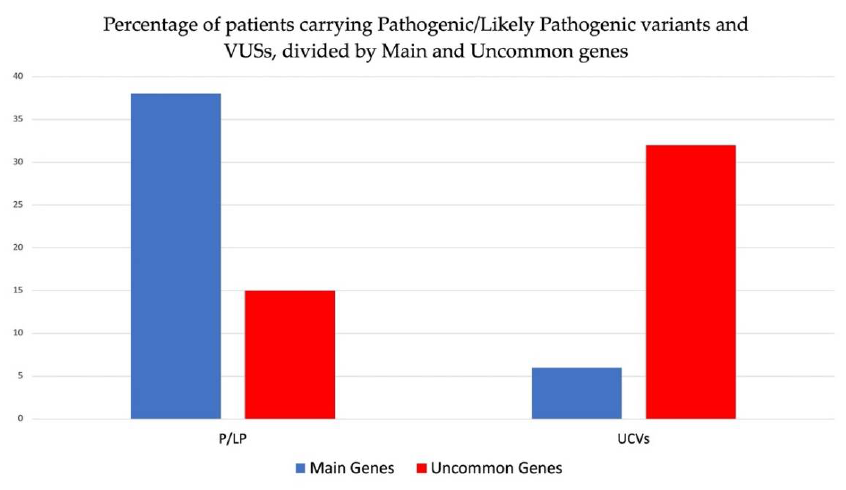
Figure 5. Percentage of patients carrying pathogenic or likely pathogenic variants and